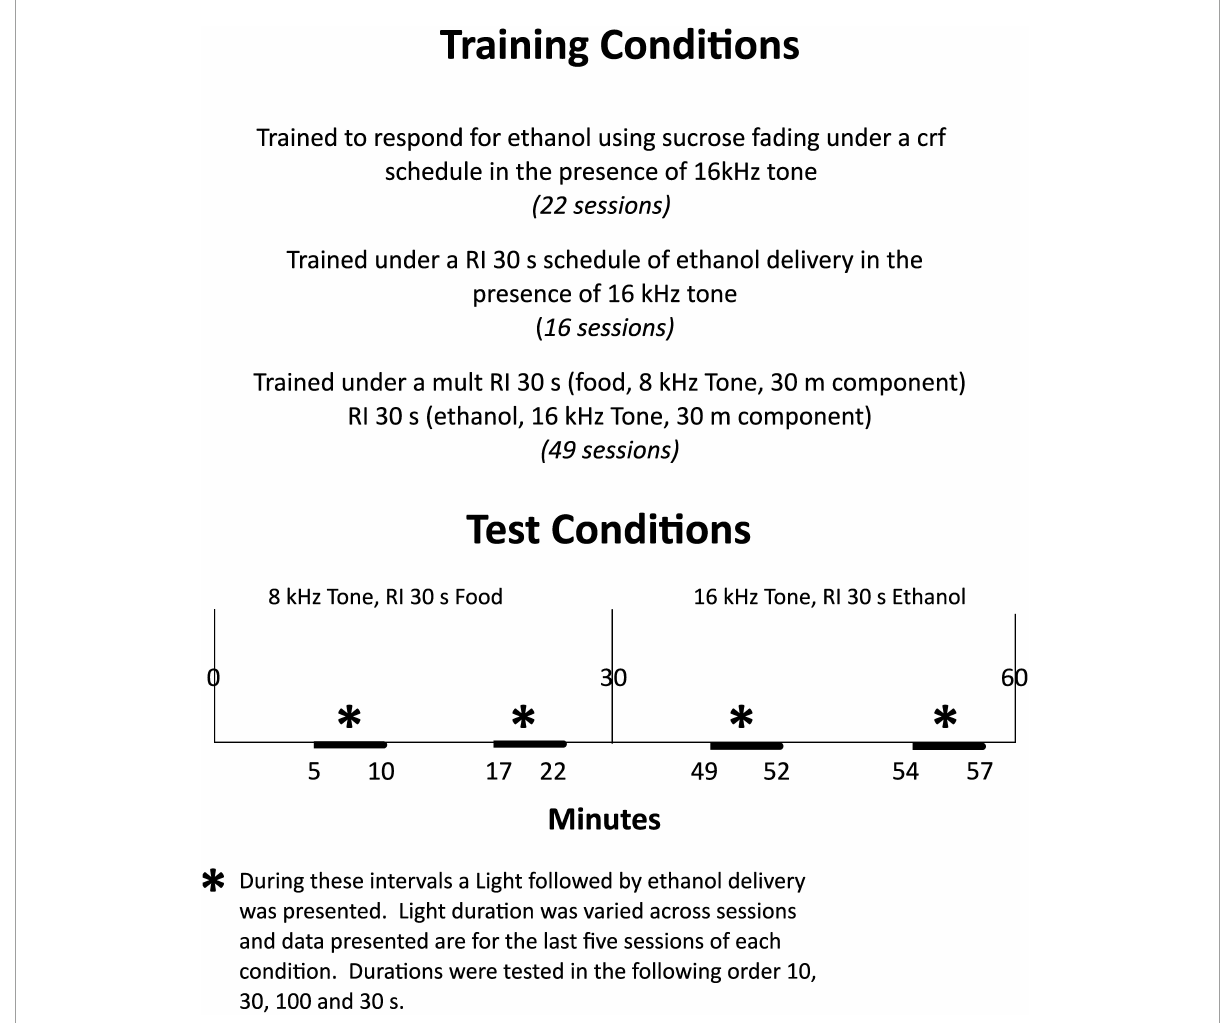
FIGURE1 Experimental design of study. Training sequence is described in the top panel and testing conditions are presented in the lower